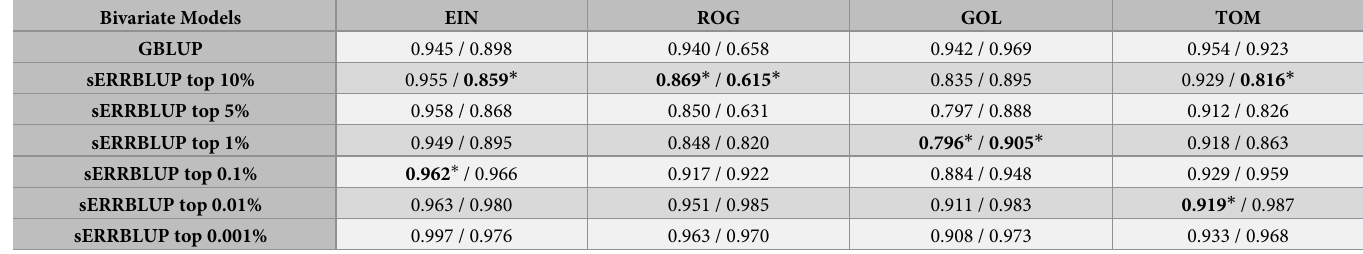
Table 4. Genomic correlation between 2017 and 2018 in each environment for trait PH_V4 for KE (blue numbers) and PE (red numbers). The blue and red bold numbers with stars indicate which proportion of interactions in bivariate sERRBLUP maximized the predictive ability based on pruned set of SNPs in each environment for KE and PE,